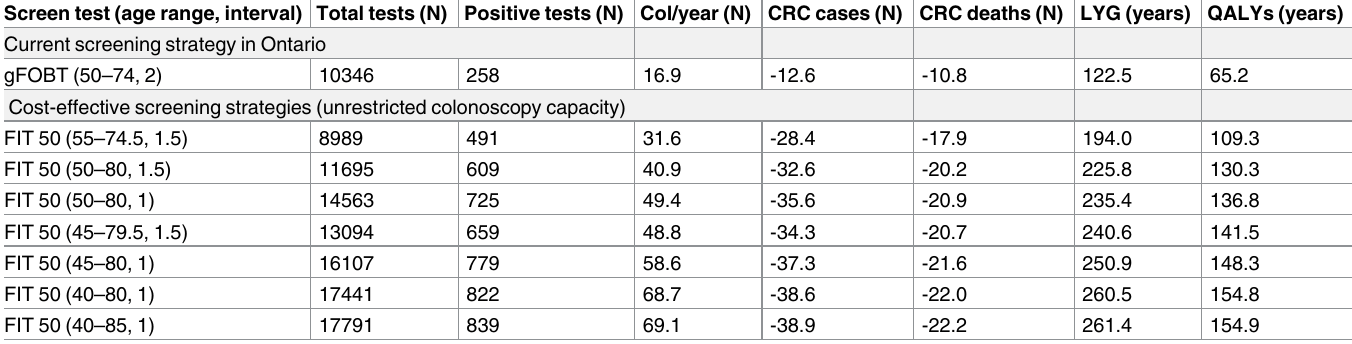
Table 5. Undiscounted intermediate model outcomes per 1,000 participants, compared to no screening.